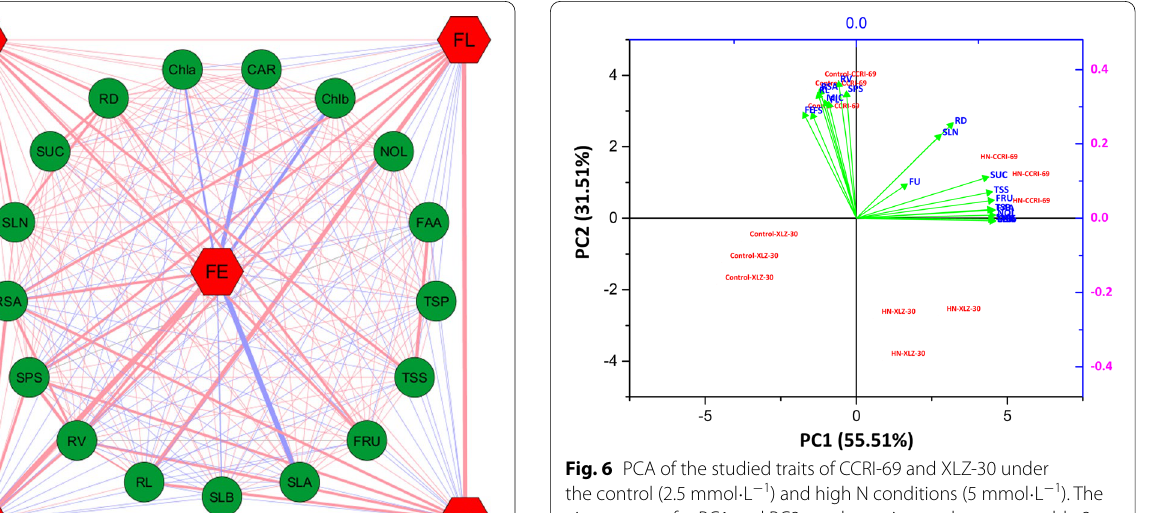
Non-significant, and * Significant at P =